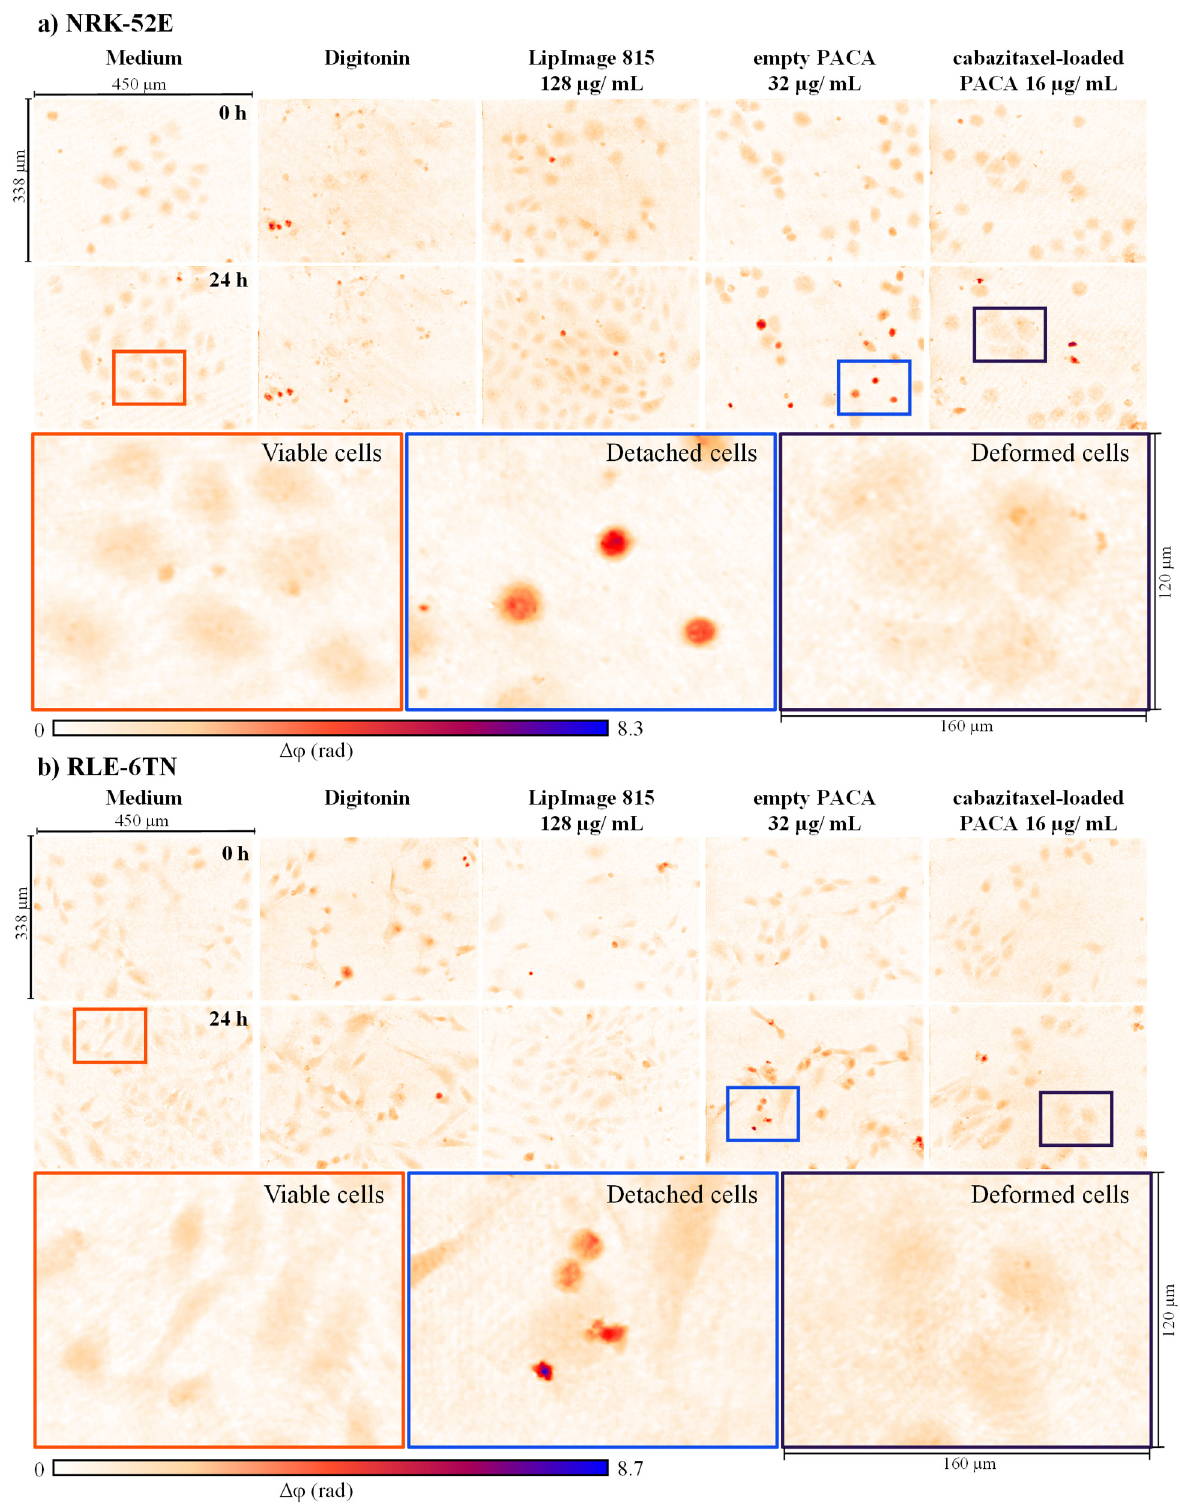
Figure 3. Representative false color-coded DHM QPI images of NRK-52E cells ( a ) and RLE-6TN cells ( b ) incubated with controls and nanoparticles at time points t = 0 h and t = 24 h. For both cell lines, cell culture medium control and cytotoxicity control digitonin is shown. In digitonin controls, cell proliferation was inhibited during the 24 h observation period—enlarged areas framed in orange show viable cells in cell culture medium control. Cells incubated with 128 µg/mL of LipImage™ 815 lipidots® nanoparticles proliferated and grew to a similar extent as observed in the cell culture medium control. Incubation with 32 µg/mL of empty PACA nanoparticles caused inhibited cell proliferation, and detached cells are shown in blue framed enlarged image areas. Incubation with 16 µg/mL of cabazitaxel-loaded PACA nanoparticles caused the deformation of cells as indicated in the purple framed enlarged image area, and proliferation was inhibited.